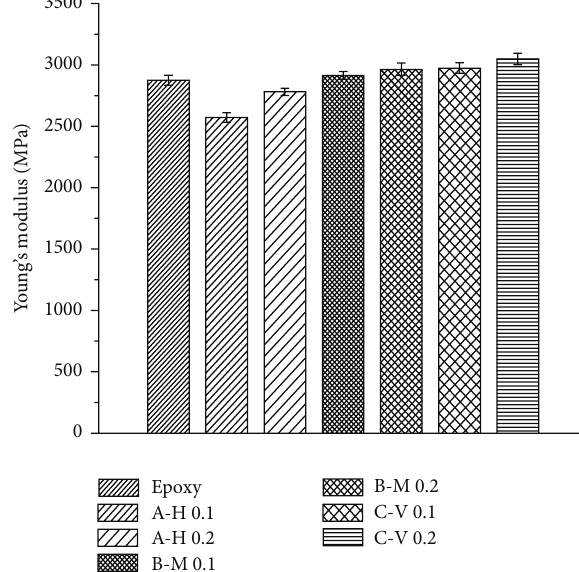
Figure 3: Young’s modulus of the test